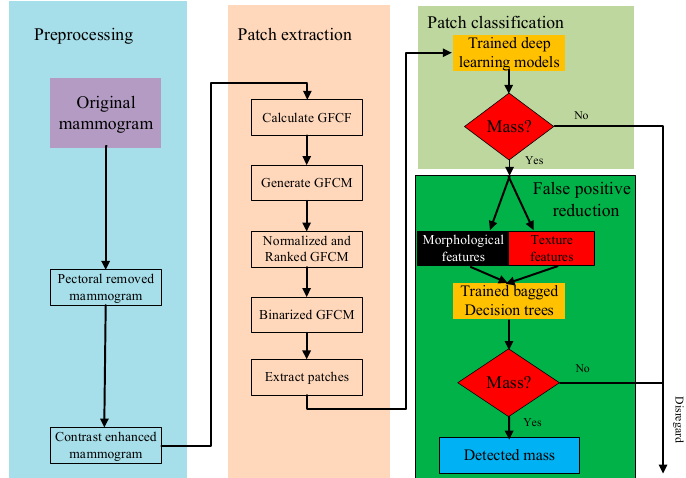
Figure 5. The fl owchart of the proposed method . Figure 5. The flowchart of the proposed